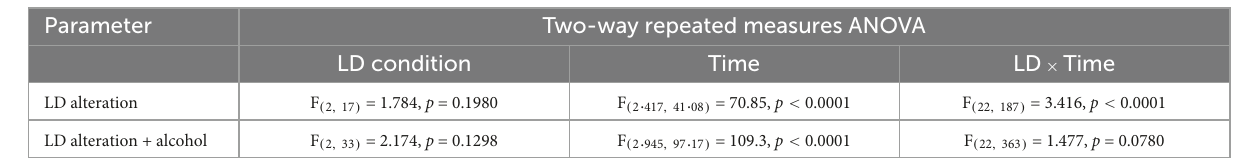
TABLE 4 Statistical results of body weight